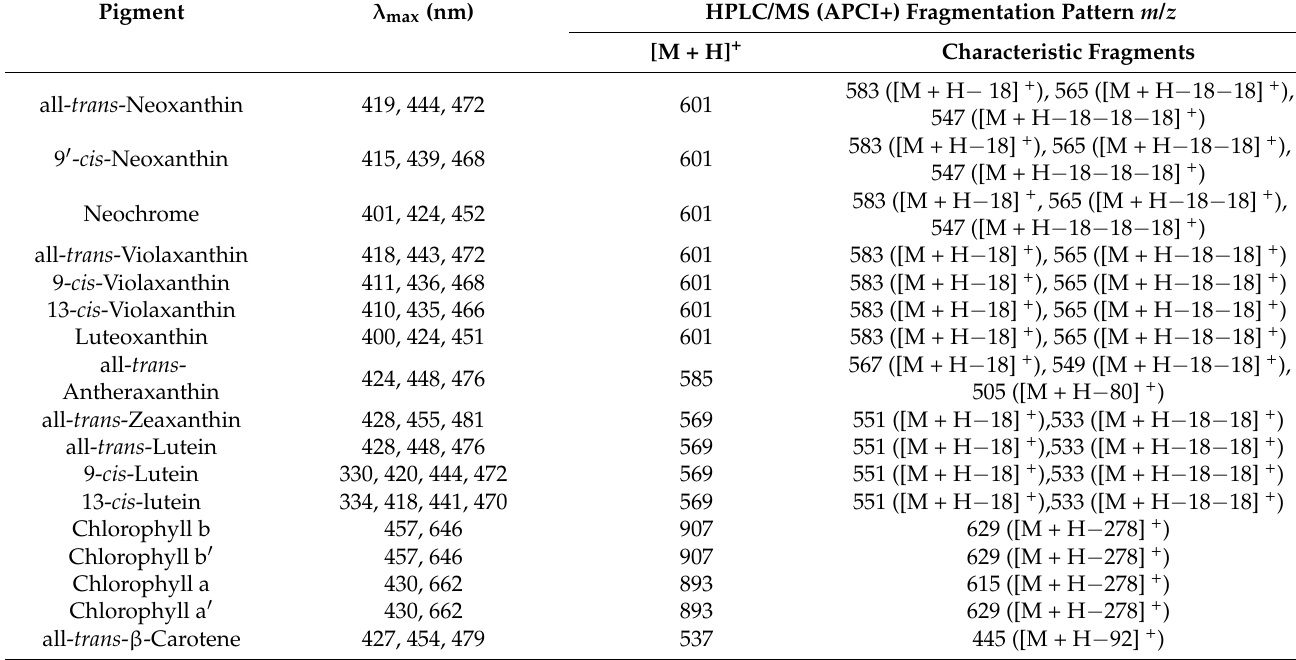
Table 5. Wavelengths of maximum absorption λ max and characteristic fragmentation pattern of the main carotenoids occurring in apples. Reproduced with the permission of Elsevier